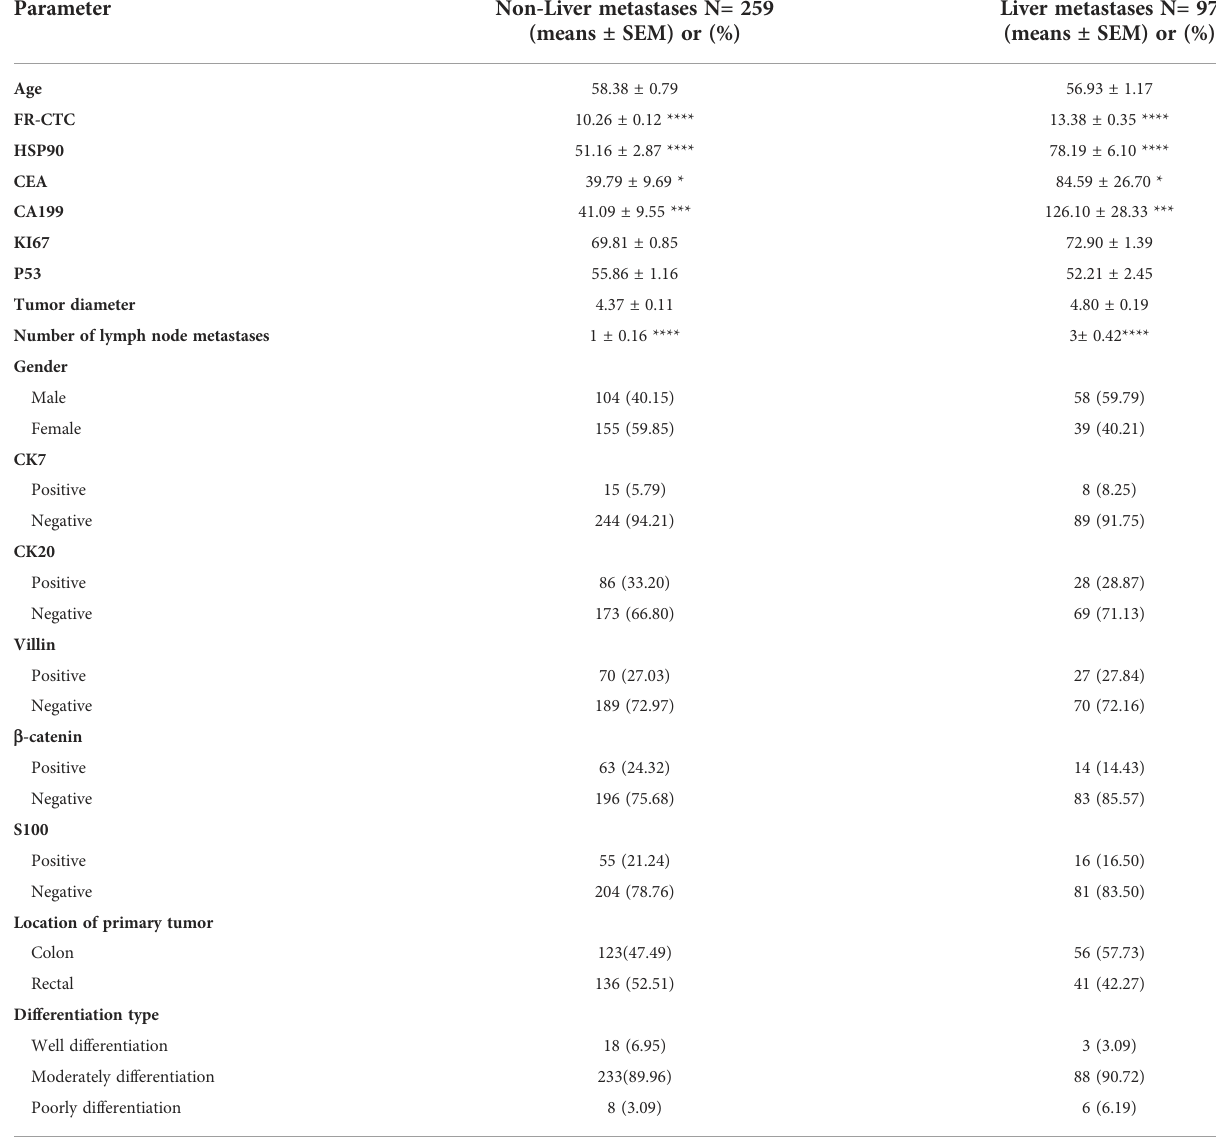
TABLE 1 Comparisons of parameters between patients with colorectal cancer and liver and non-liver metastases.